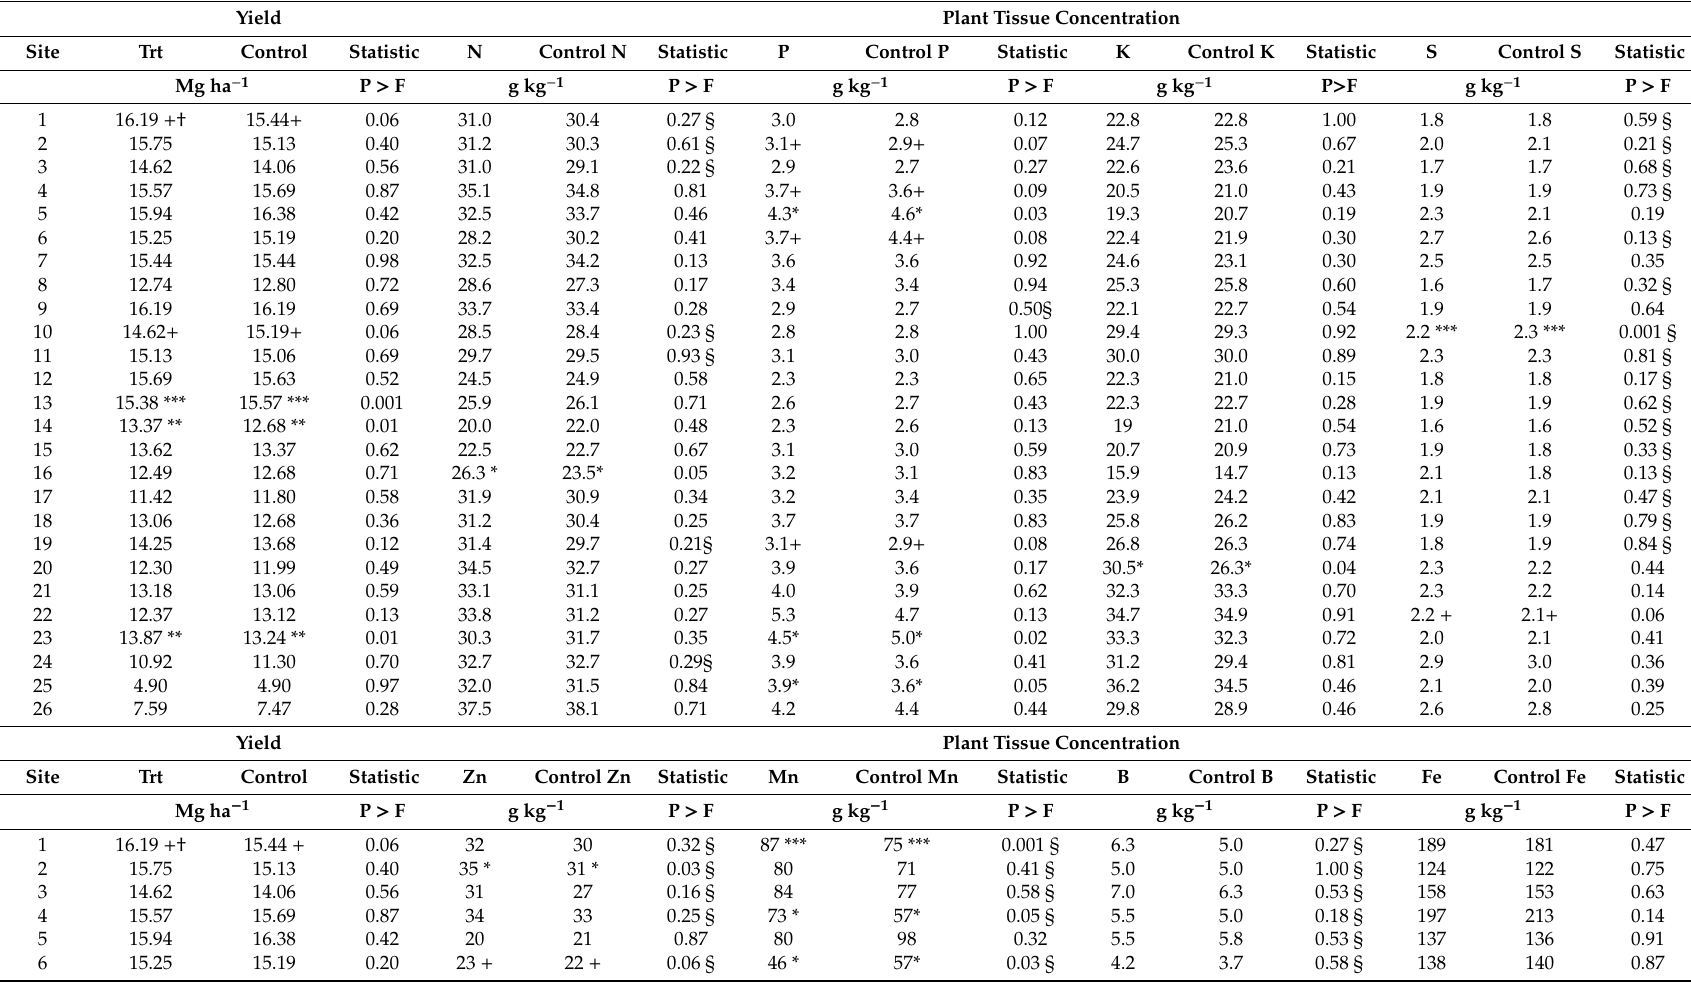
Table 4. Maize yield and leaf tissue nutrient concentration without foliar micronutrient application and the response to